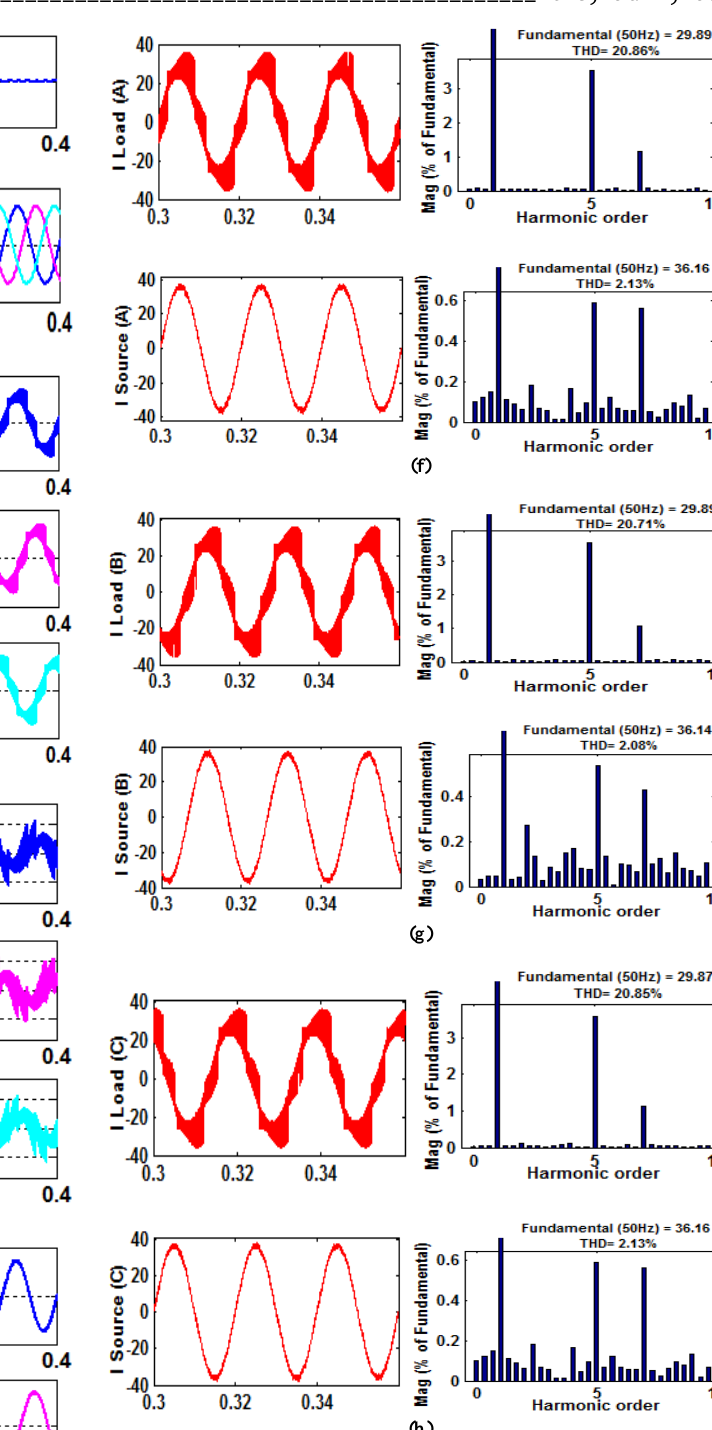
Fig. 11. The performance of the proposed STATCOM control under balanced non-linear load: (a) DC capacitor voltage; (b) voltage at PCC; (c) load current profiles separately for all three phases; (d) STATCOM (inverter) compensating current profiles separately for all three phases; (e) compensated source current profiles separately for all three phases. Harmonic spectra of load currents and compensated source currents for (f) phase a; (g) phase b; (h) phase